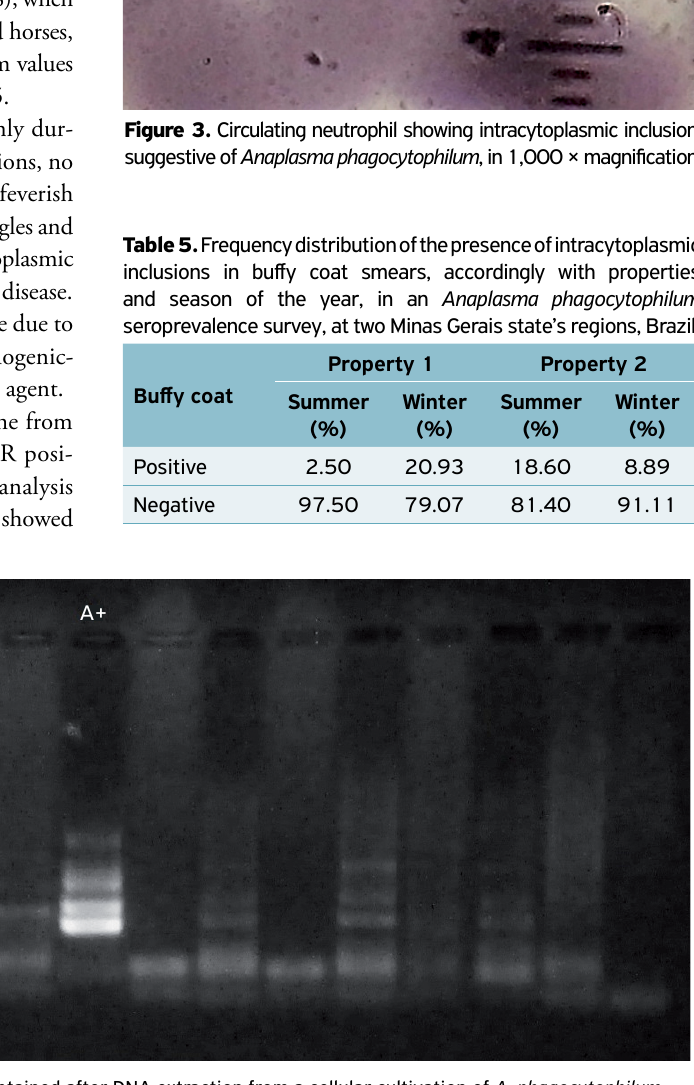
P: Standard, molecular weight 1 Kb; C+: positive control, obtained after DNA extraction from a cellular cultivation of A. phagocytophilum ; A+: positive sample; two last gutters as filled with the white reaction from first and second reactions, Figure 4. 1% agarose gel showing a positive sample to Anaplasma phagocytophilum .